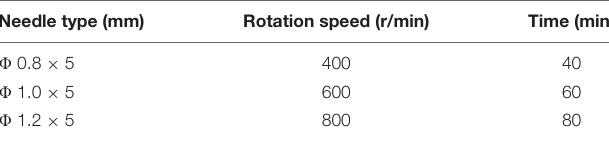
TABLE 2 | Group parameters of response surface.